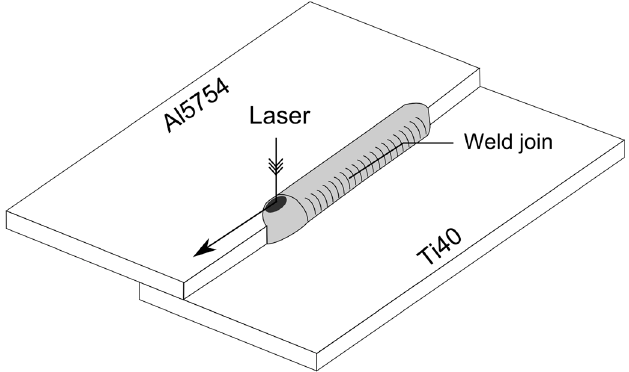
Figure 1. Scheme of the welding-brazing overlap configuration.